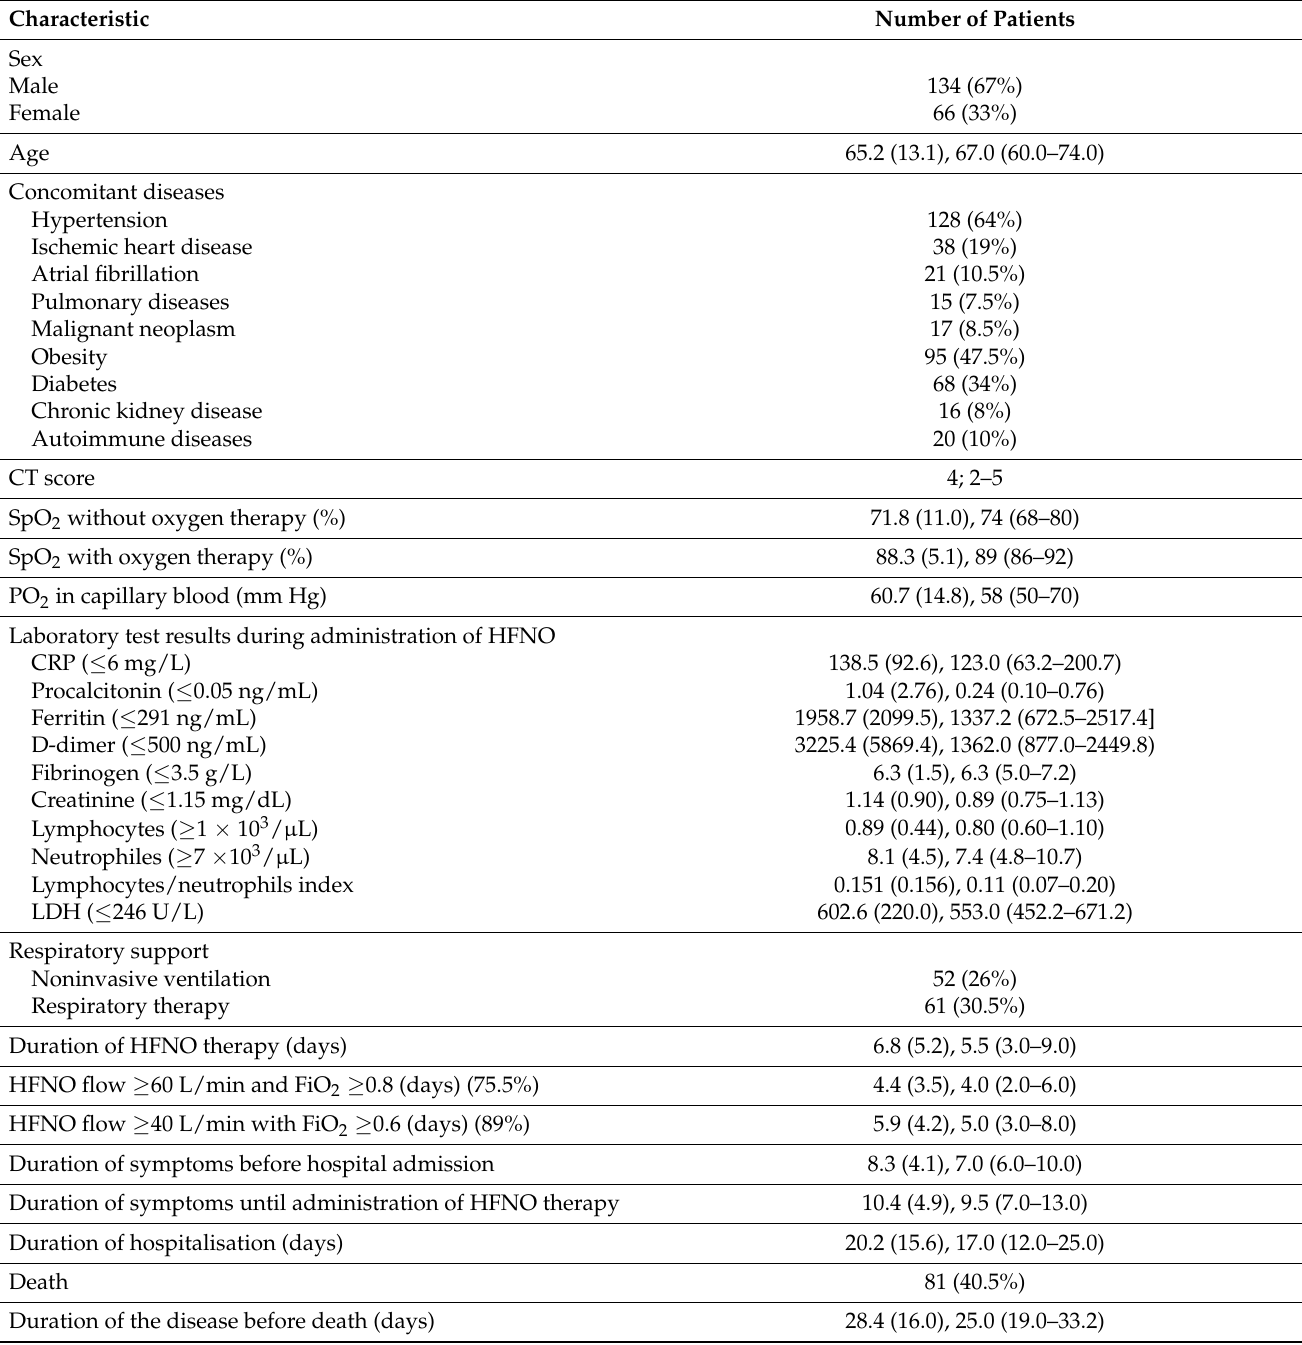
Table 7. Baseline demographics and clinical characteristics ( n =